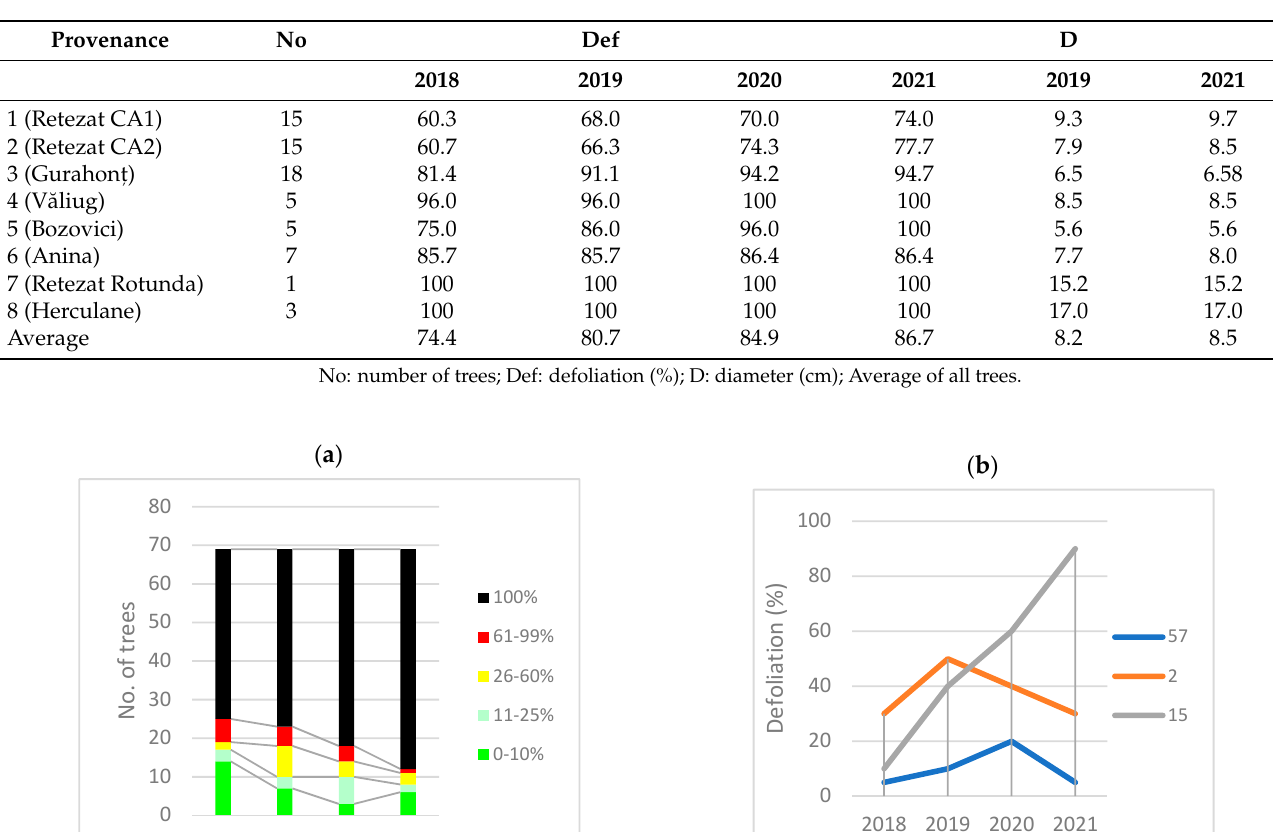
Table 5. Defoliation and diameter of Ulmus glabra provenances.